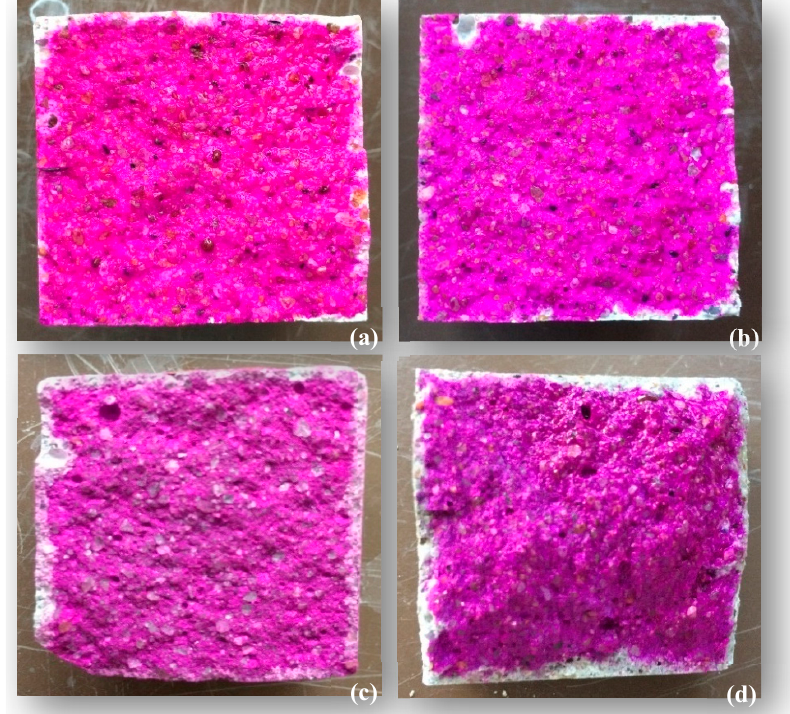
Figure 4. Carbonation of W ( a ), W-10 ( b ), G ( c ) and G-10 ( d ) at 365